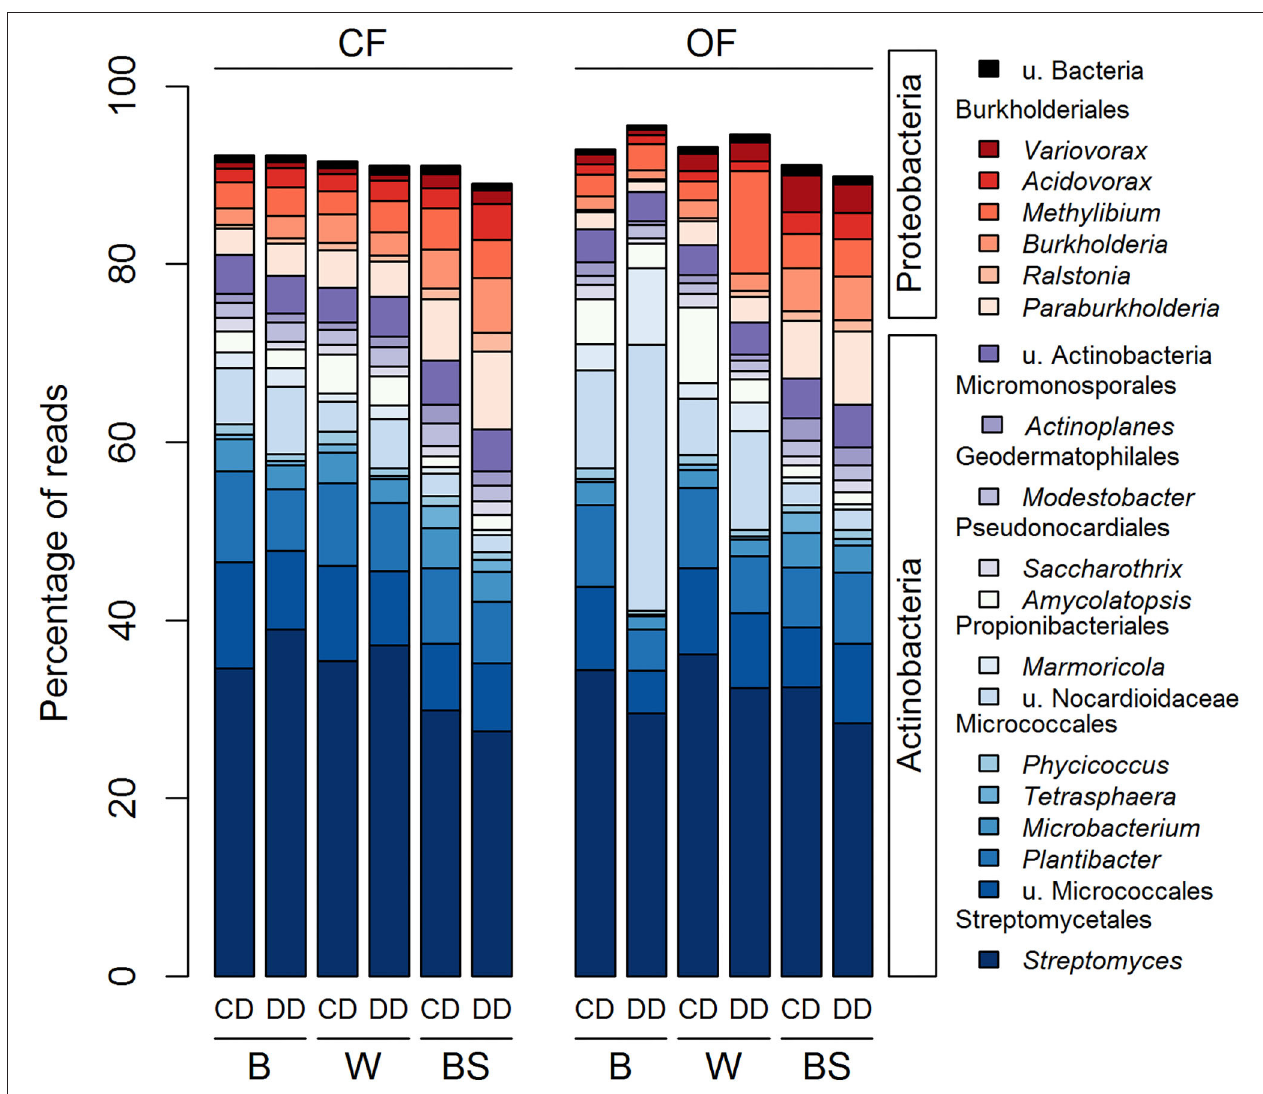
FIGURE 5 | Distribution of the 20 most abundant genera across all treatments based on the acdS dataset. CF, conventional farming; OF, organic farming; B, barley; W, wheat; BS, bare soil; CD, “single water deficit,” control and dry conditions; DD, “water deficit history,” dry conditions and dry conditions; n = 5 pots.